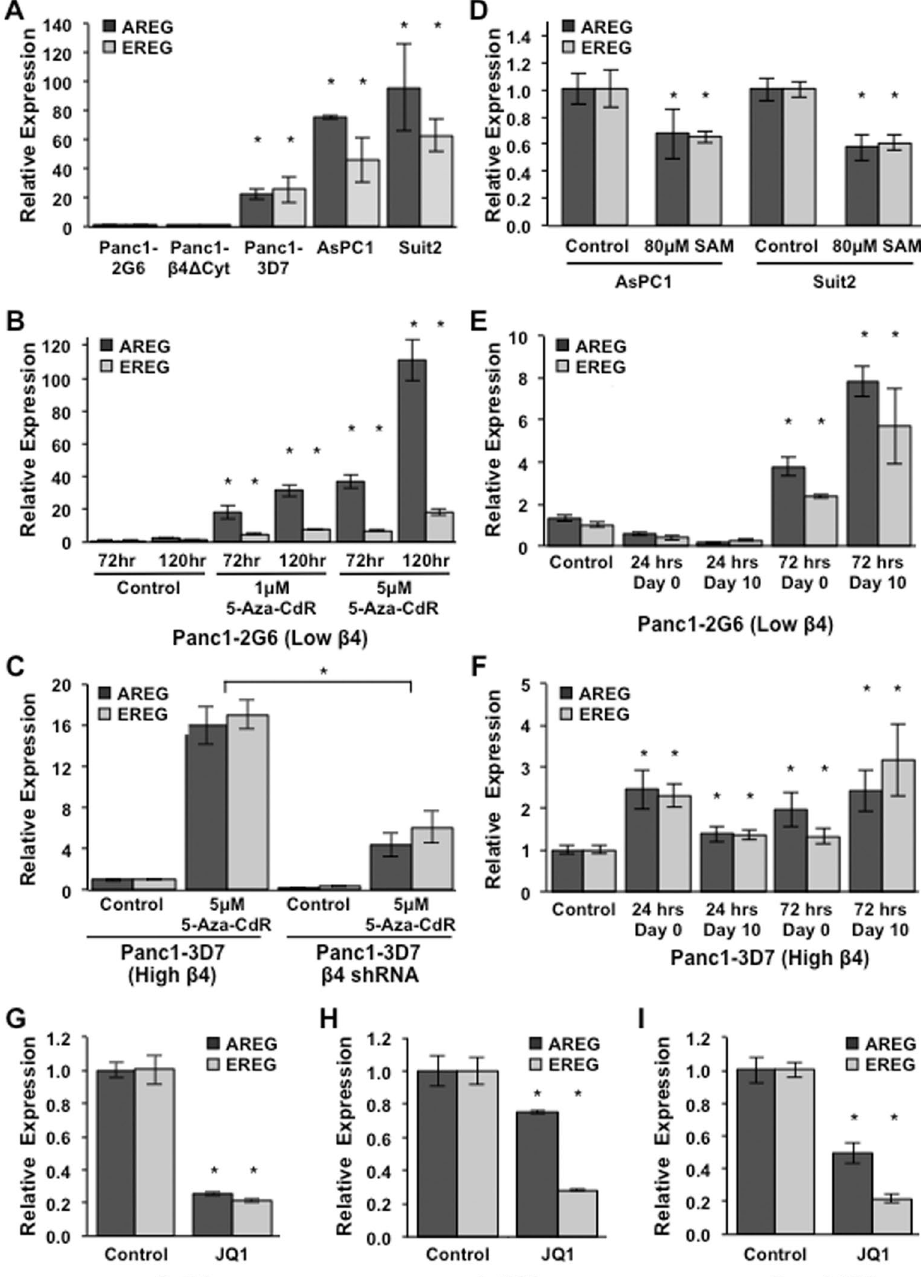
Figure 2. AREG and EREG expression is mediated by DNA demethylation in response to signaling from the integrin α 6 β 4. ( A ) Expression of AREG and EREG was compared in Panc1-2G6 (low α 6 β 4) and cells expressing a dominant negative α 6 β 4 (Panc1- β 4 Δ Cyt), Panc1-3D7, Suit2, and AsPC1 (high α 6 β 4; in order of increasing expression) cell lines. ( B ) Panc1-2G6 cells (low α 6 β 4) were treated with vehicle only (control) or with 1 μ M or 5 μ M 5-aza-2 ′ -deoxycitine (5-aza-CdR) in fresh medium daily for 3 or 5 days. ( C ) Panc1-3D7 stably expressing an shRNA targeting the β 4 subunit or a non-targeting (NT) shRNA control vector were treated with 2 μ M 5-aza-CdR for 3 days and then assessed for AREG and EREG expression. ( D ) AsPC1 and Suit2 (high α 6 β 4) were treated with vehicle only (control) or 80 μ M S-adenosylmethione (SAM) in fresh medium daily for 5 days ( E , F ). Panc1-2G6 ( E ) and Panc1-3D7 ( F ) cells were treated with 2 μ M 5-aza-CdR for 24 or 72 hours, 5-aza-CdR was removed and cells were either collected immediately or maintained in culture for 10 days. ( G – I ) Cells with high integrin α 6 β 4 were treated with vehicle only (control) or 0.5 μ M JQ1 overnight and harvested for analysis by QPCR. For all experiments RT-PCR was used to convert RNA to cDNA and QPCR was used to assess AREG and EREG expression. Data depicted here are representative of at least three different experiments and represent the mean + / − standard deviation. Statistical significance was calculated using a one-tailed t-test in which * denotes P < 0.05 as compared to controls, unless otherwise